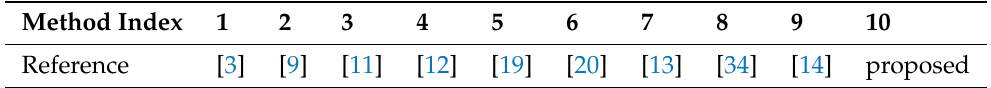
Table 3. Comparative studies of PS